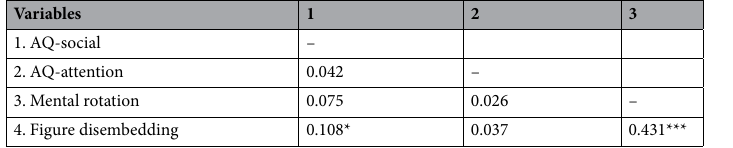
Table 2. Correlations among social traits, non-social traits, mental rotation and figure disembedding performance. * p < 0.05. *** p < 0.001.